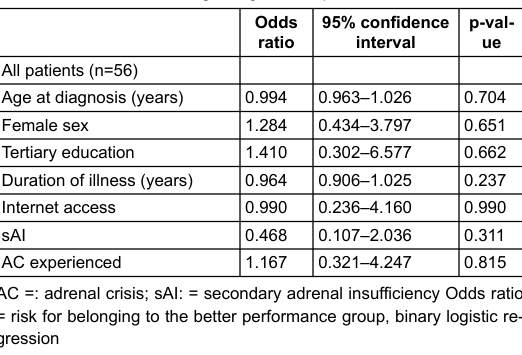
Table 9: Factors contributing to a good test performance in Part